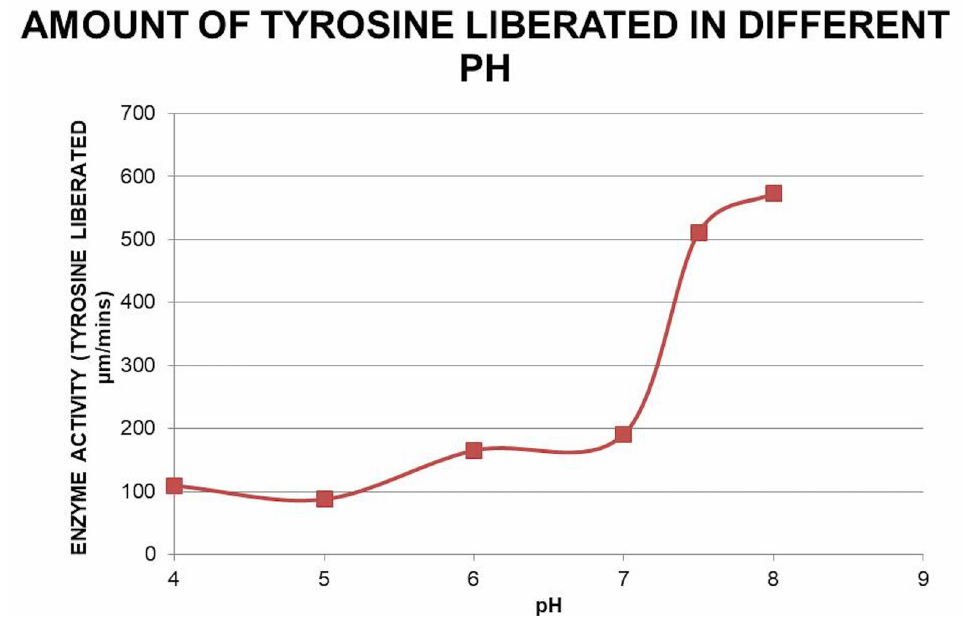
Figure 4. Effect of pH on the caseinolytic property of the protease. Protease activity of the pooled pure fractions on β -casein degradation is plotted against different pH (4, 5, 6, 7 and 8) at 37ºC. Free tyrosine liberated due to β -casein degradation was monitored with Folin-Ciocalteau reagent at 660 nm and the corresponding amount was measured from the tyrosine standard curve.